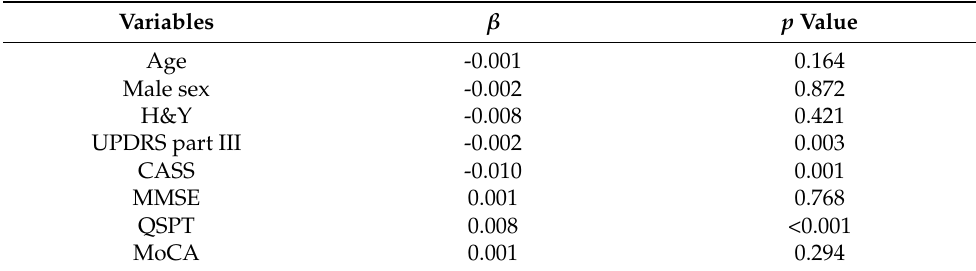
Table 2. Results of univariate analyses.